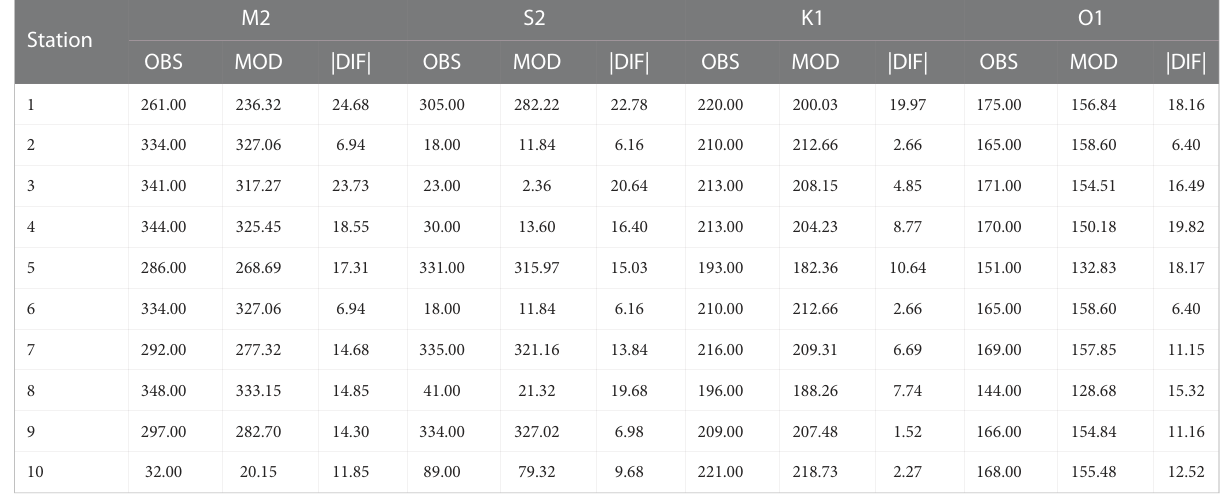
TABLE 2 The comparison of phases (°) between the observation and simulation of the major four tidal components.